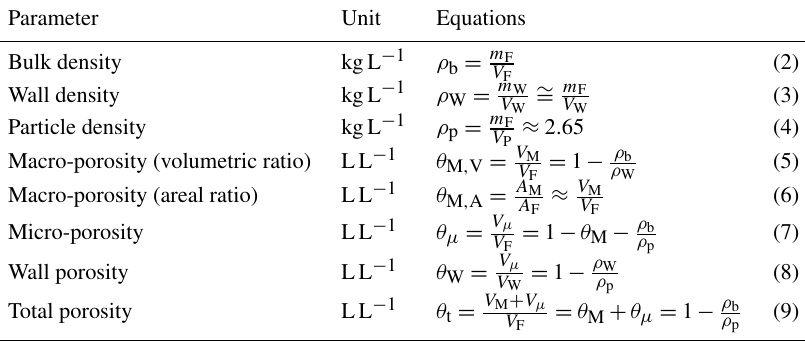
Table 1. Calculation of TM internal parameters from physical measures of mass, volume and area fractions (see Fig. 1). The TM mass m F refers to dry mass; water content was determined from the oven-dry weight and subtracted from field weight. Mass of termites and potential food stores were considered negligible; thus m F is essentially identical to the mass of wall material, m W . Particle density ρ b of the TM was assumed to be 2.65kgL − 1 , typical for soil